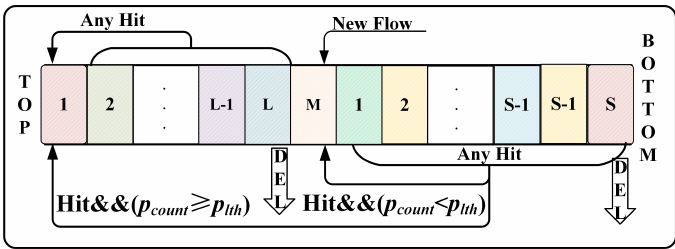
Figure 7. Schematic diagram of